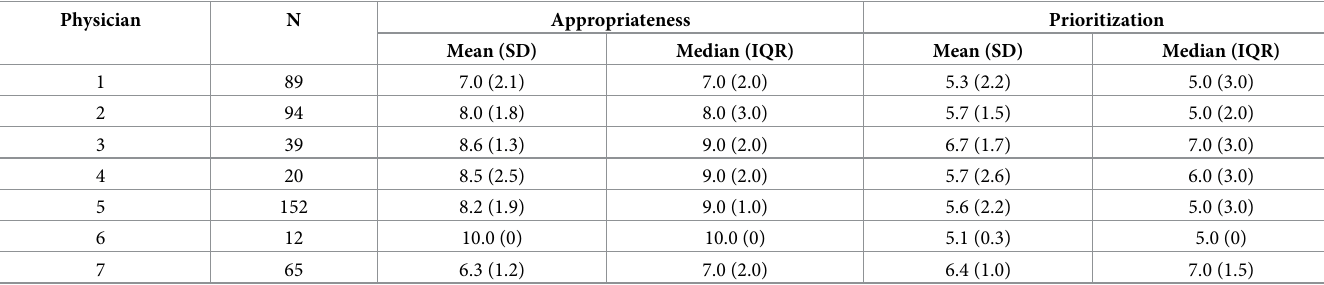
Table 2. Physician appropriateness and prioritization